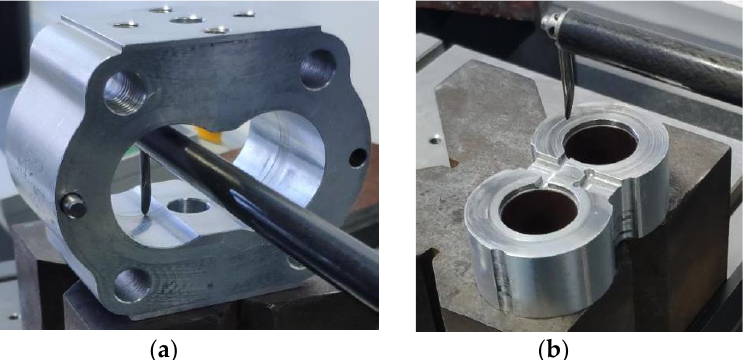
Figure 24. Enlarged drawing of wear measurement part: ( a ) radial wear measurement; ( b ) end face wear measurement.